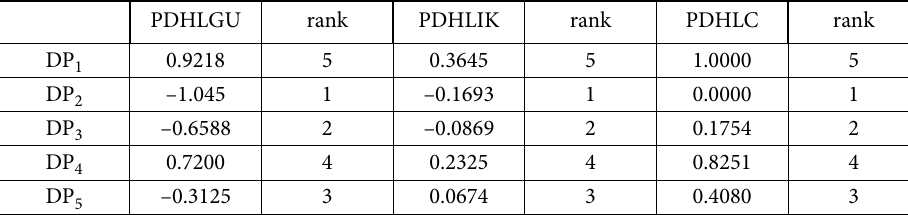
Table 21. The numerical results and rank derived by the